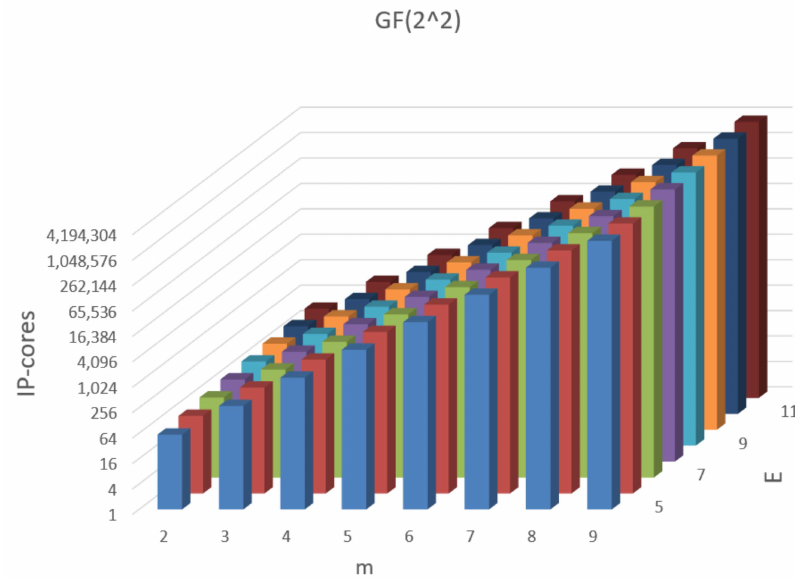
Figure 1. Total number of IP-cores for a group of polynomials over GF ( 2 2 ) .